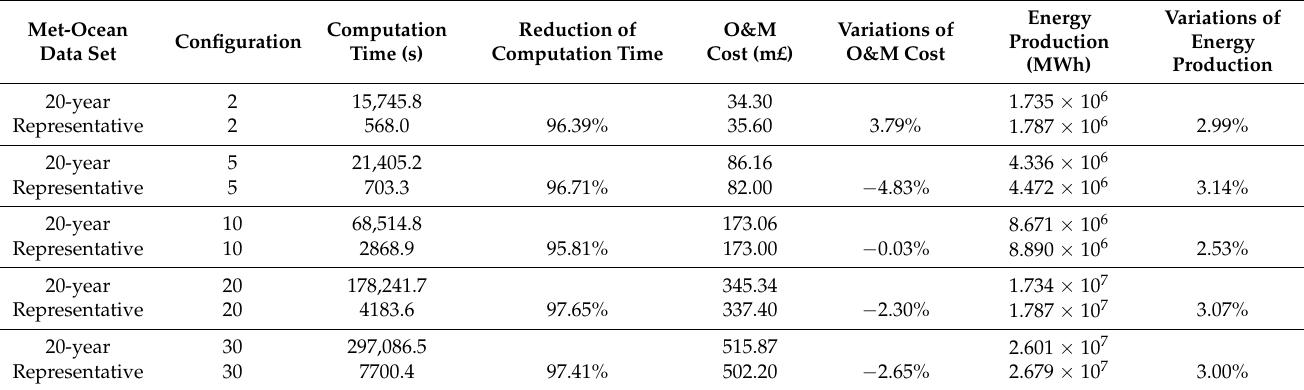
Table 4. O&M simulation results of different wind farm configurations using 20-year and representa- tive met-ocean